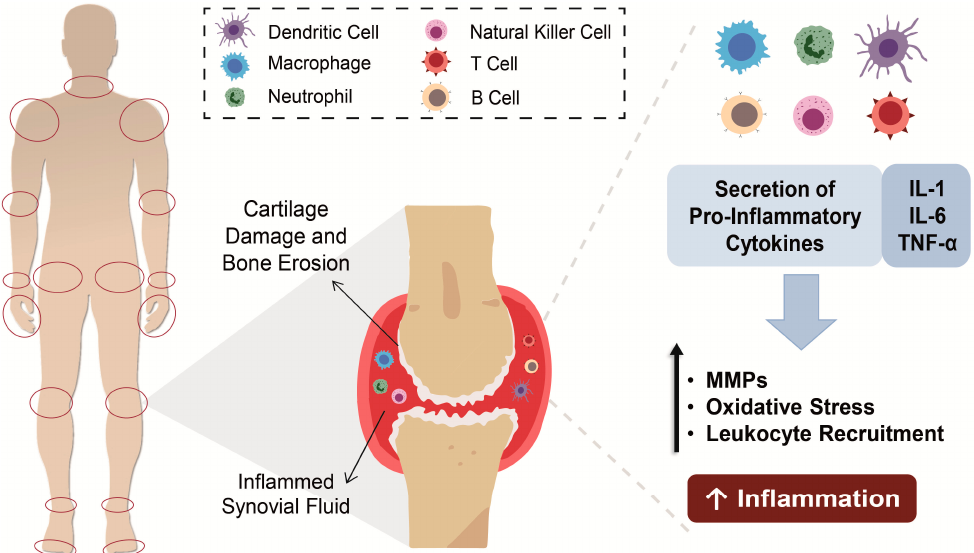
Figure 1. Overview of rheumatoid arthritis (RA) pathogenesis: inflammatory cells produce proinflammatory markers (e.g., cytokines) in the inflamed synovium of joints, enhancing the production of metalloproteinases (MMPs) that cause bone erosion; increasing the oxidative stress by production of reactive oxygen or nitrogen species (ROS, RNS respectively) and recruiting more leukocytes into the joint, exacerbating the inflammation. IL—interleukin; TNF- α —tumor necrosis factor-alpha.